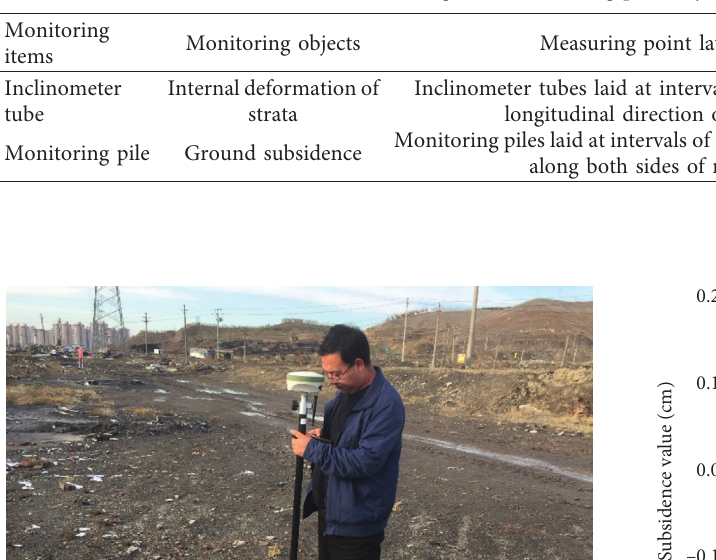
Figure 27: Distribution location of monitoring points. Table 5: Monitoring items, measuring point layout, and monitoring accuracy.